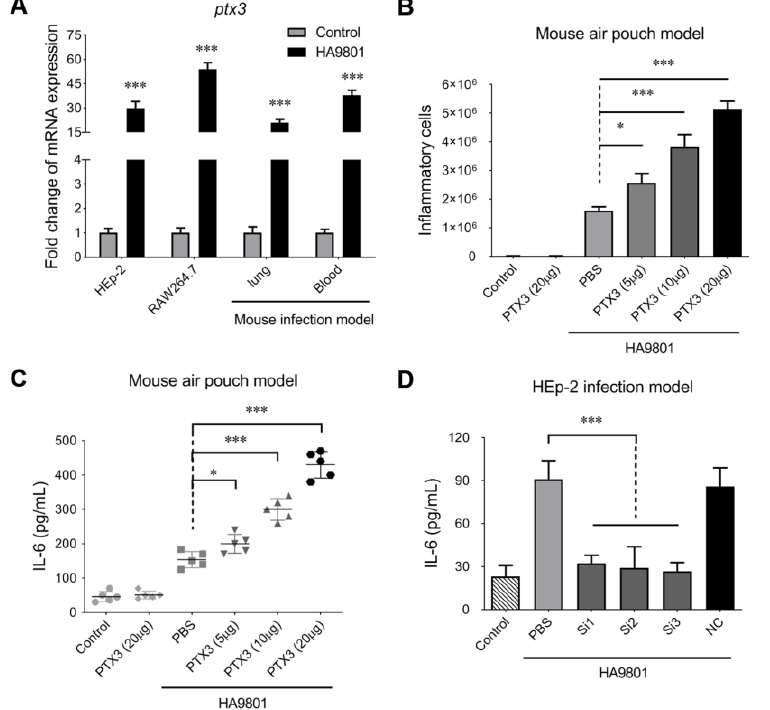
Figure 1. PTX3 contributed to the host inflammatory response during the infection of SS2 strain HA9801. ( A ) the expression of PTX3 in the indicated host cells and organs infected with strain HA9801. The treatments of equal volume PBS were used as control. ( B , C ) The recruitment of inflammatory cells (including neutrophils and monocytes identified by the microscopic observation) and release of cytokine IL-6 in the mouse air pouch model infected by strain HA9801 (3 × 10 8 CFU/mouse) mixed with various doses of PTX3 protein. ( D ) HEp-2 cells were transfected with PTX3 siRNA (Si1-3) or negative control siRNA (NC), and then infected with SS strain HA9801 for 24 h to detect the levels of cytokine IL-6. Statistical significance was determined by a two-tailed unpaired Student’s t -test based on comparisons with the PBS group (* p <0.05; *** p <